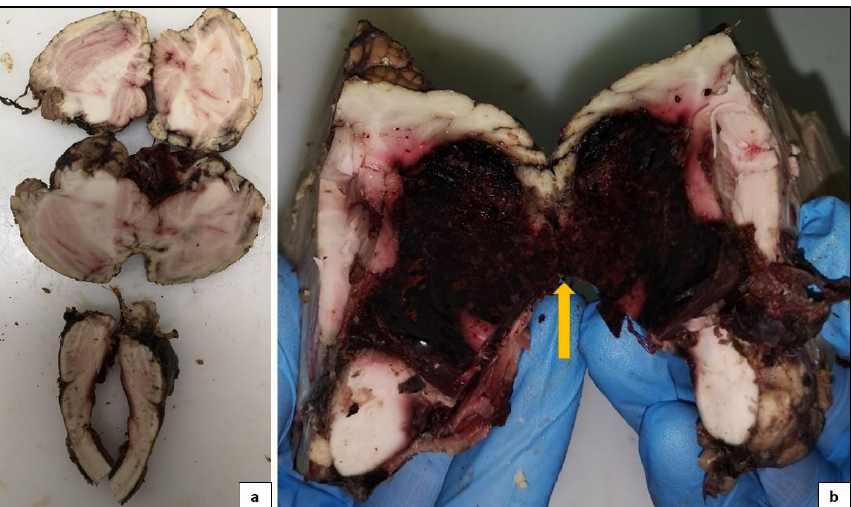
Figure 5. Different cutting surfaces on the cerebellum and oblongata medulla. ( a ) First cutting sur- face performed along the median axis of the oblongata medulla and across the cerebellum showing hemorrhagic infarction on fourth ventricle sides, as well as several small reddish infarctions across the entire cerebellum parenchyma. ( b ) Second cutting surface on the superior part of the cerebellum shows a massive hemorrhagic infarction that extends to the edge of the fourth ventricle.